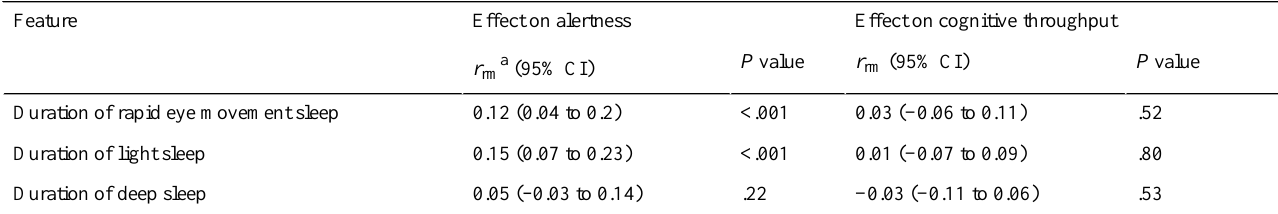
Table 6. Effect of sleep stages on daytime alertness and cognitive throughput.